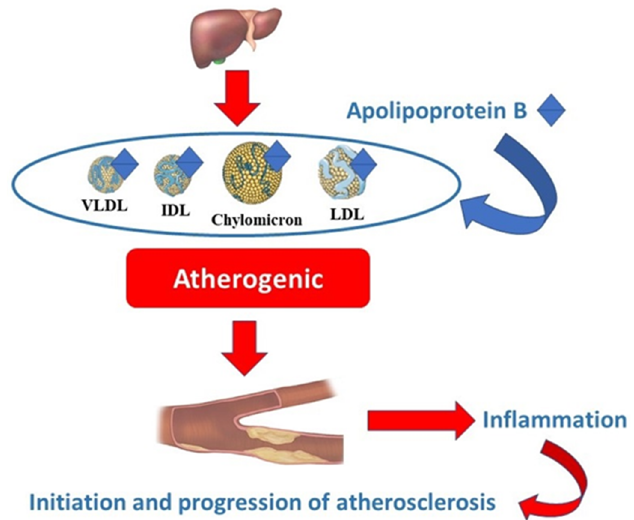
Figure 1. The link between Apo B and atherosclerosis. VLDL—very low-density lipoprotein; IDL—intermediate-density lipoprotein; LDL—low-density lipoprotein.